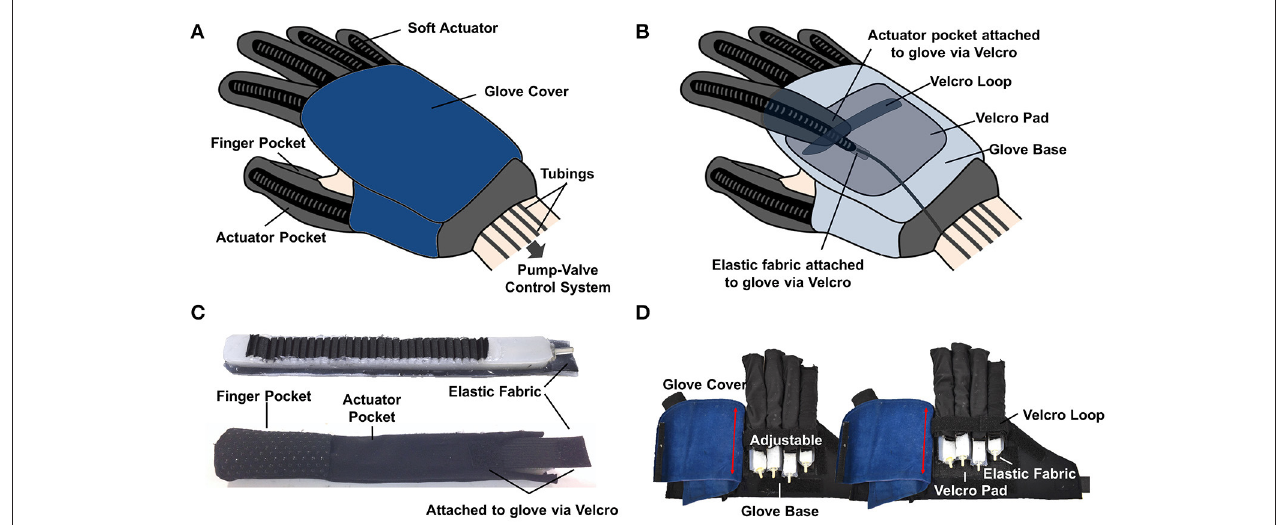
FIGURE 3 | (A) Outer view and (B) inner view of the soft robotic glove. (C) Actuators are inserted into actuator pockets. (D) The length of the finger-actuator pockets can be adjusted and attached to the base of the glove via